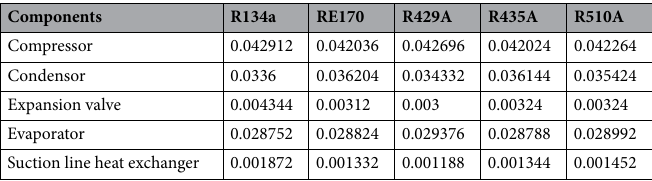
Table 5. Exergy losses in various components (kW).